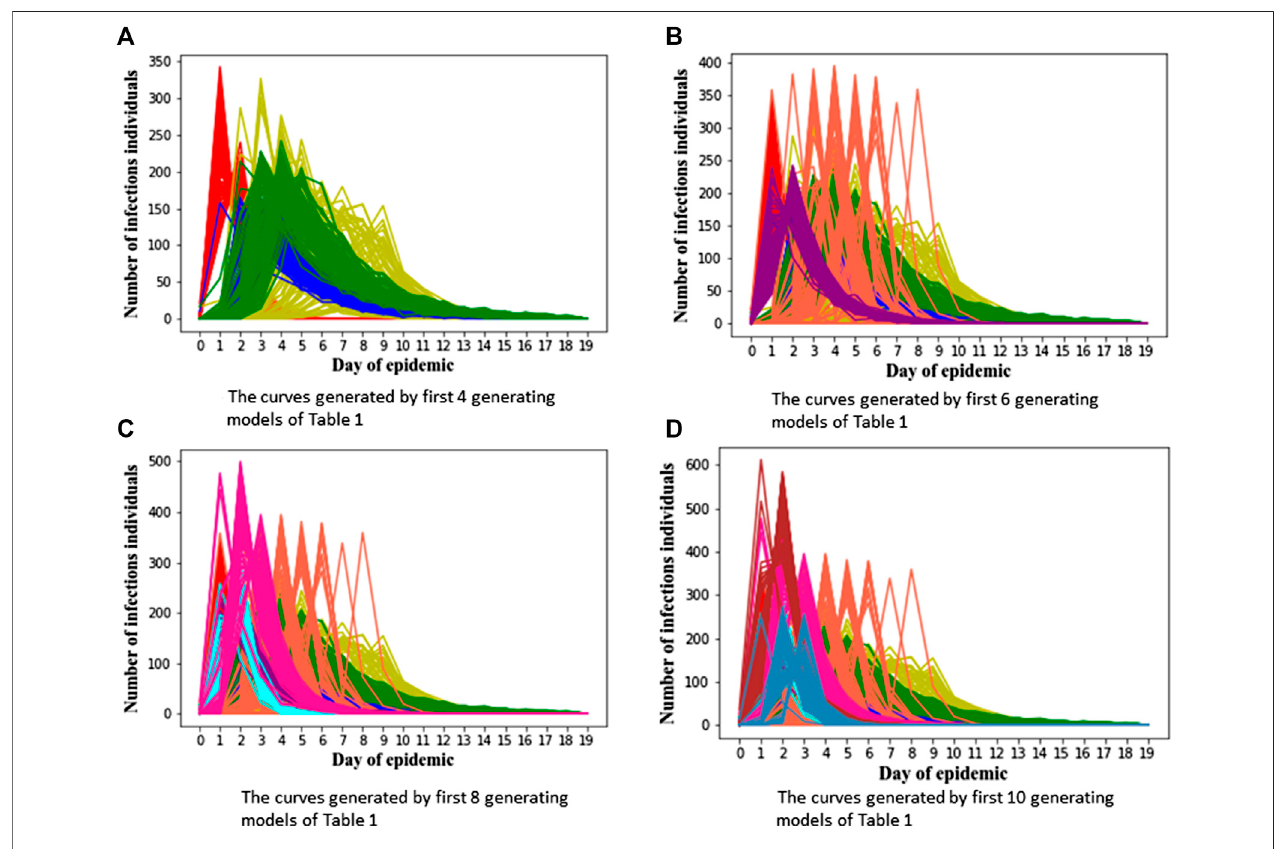
FIGURE 1 | Epidemic curves generated under various training sets.